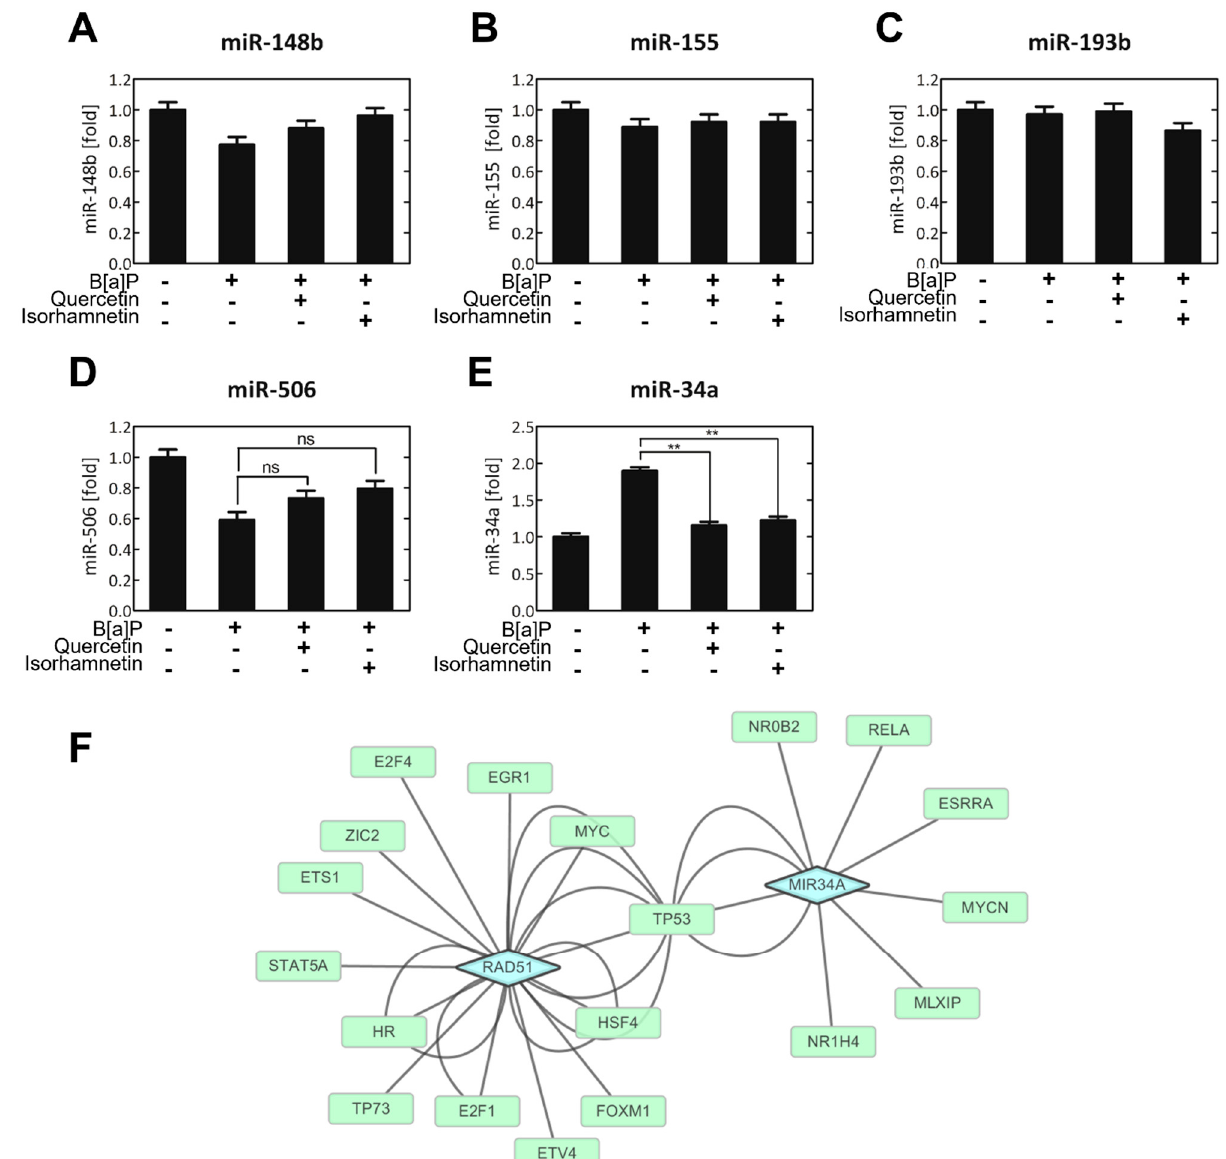
Figure 4. Quercetin or isorhamnetin downregulated the cellular level of miR − 34a, which targets the RAD51 transcript. The cellular levels of ( A ) miR − 148b, ( B ) miR − 155, ( C ) miR − 193b, ( D ) miR − 506, and ( E ) miR − 34a were assessed. ( F ) Pathway analysis based on Signaling Pathways Integrated Knowledge Engine (Spike) database was performed to confirm the relation between RAD51 and miR − 34a. ns; not significant. ** p < 0.01, C; control, Q; quercetin, I; isorhamnetin, B;